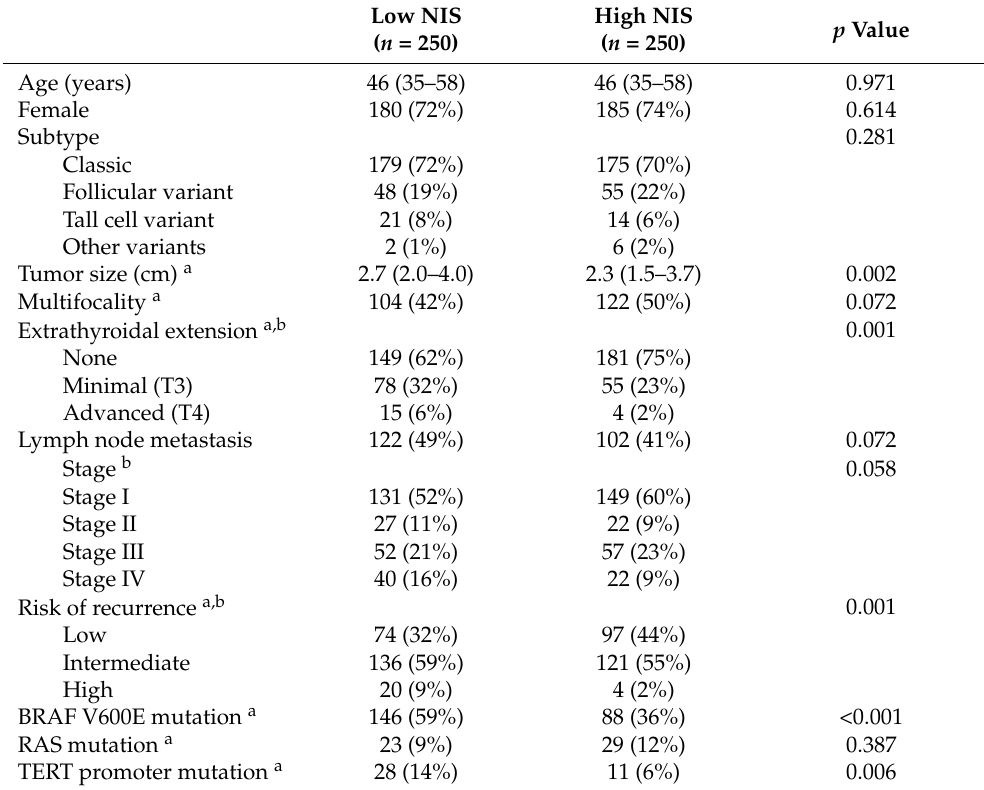
Table 1. Clinicopathologic features of the TCGA-THCA patient cohort, grouped according to the expression of sodium iodide symporter (NIS) by median split.